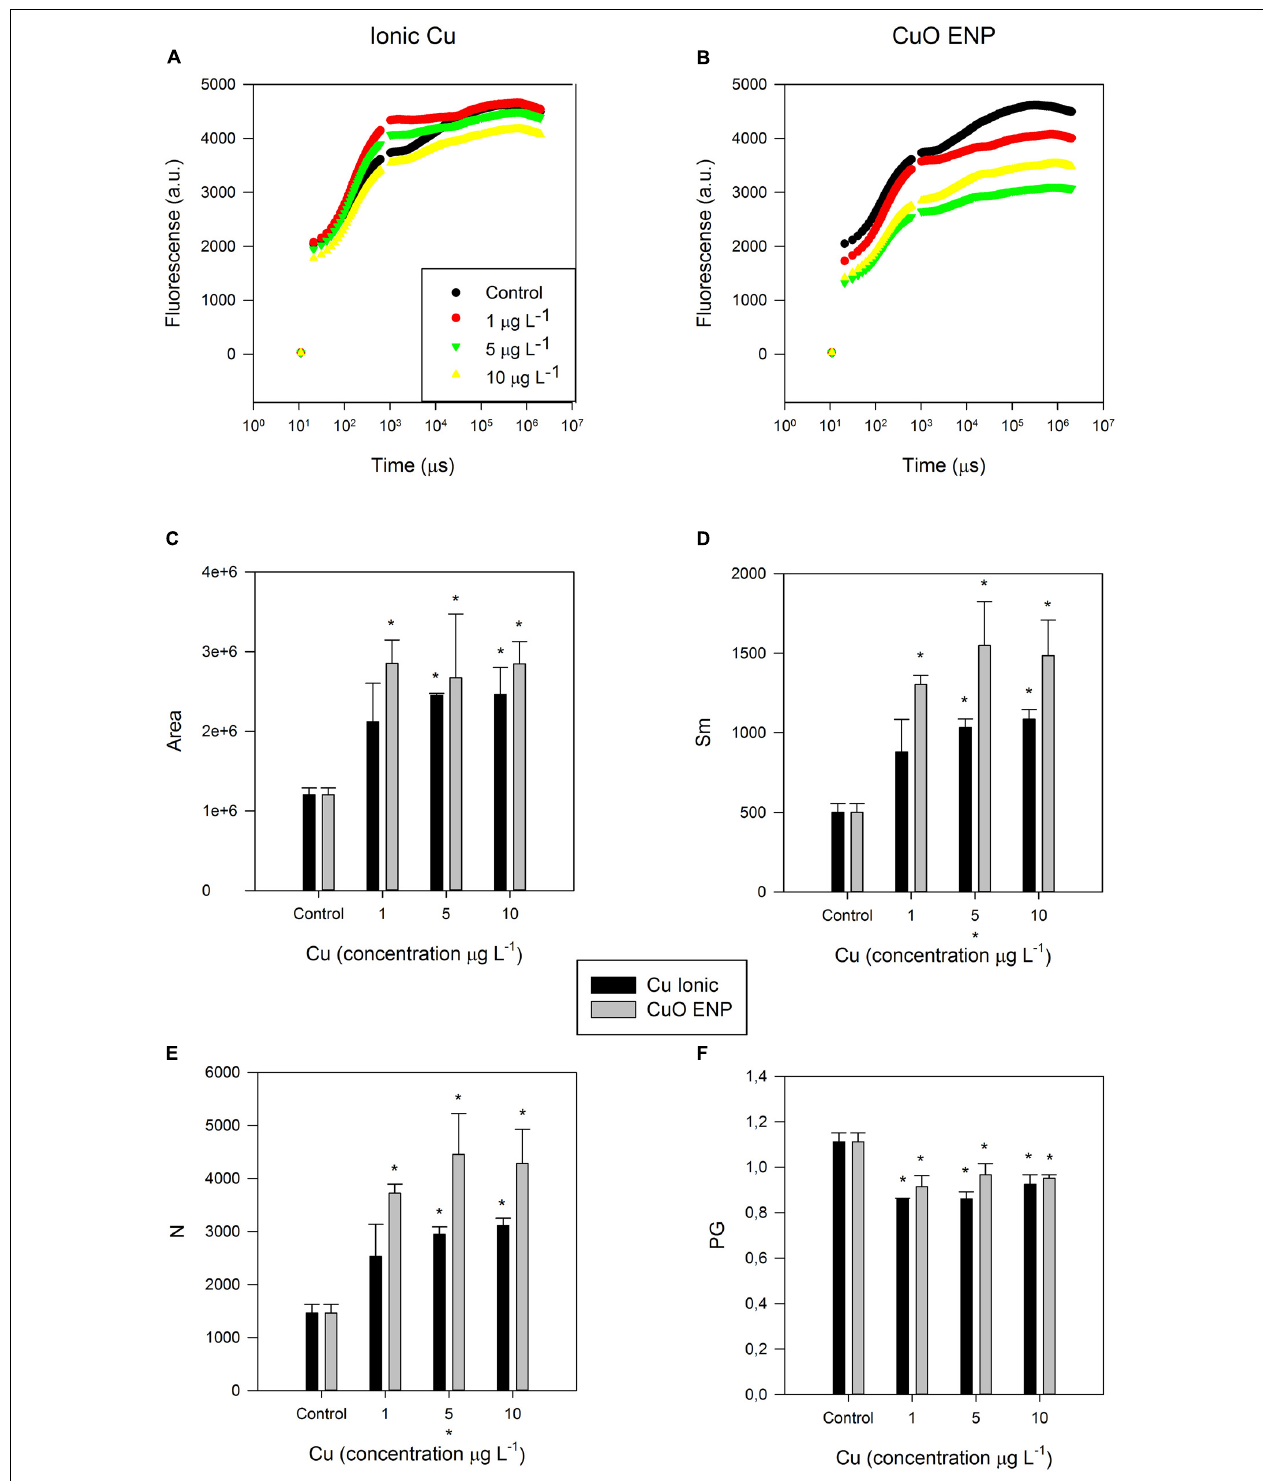
FIGURE 4 | (A,B) Kautsky curves obtained from dark-adapted samples; OJIP-derived parameters, namely (C) size (Area) of the oxidized quinone pool, (D) energy needed to close all Reaction Centers (Sm), (E) total number (N) of electrons transferred in the electron transport chain, and (F) disconnectivity between PS II antennae (P G ), in P. tricornutum , after 3 days of exposure to increasing ionic Cu (black bars) and CuO ENP (gray bars) concentrations (average ± standard deviation, N = 3, *above bars indicate significant differences compared with the control at p < 0.05, whilst *below x -axis indicate significant differences between ionic Cu and CuO ENP at a same